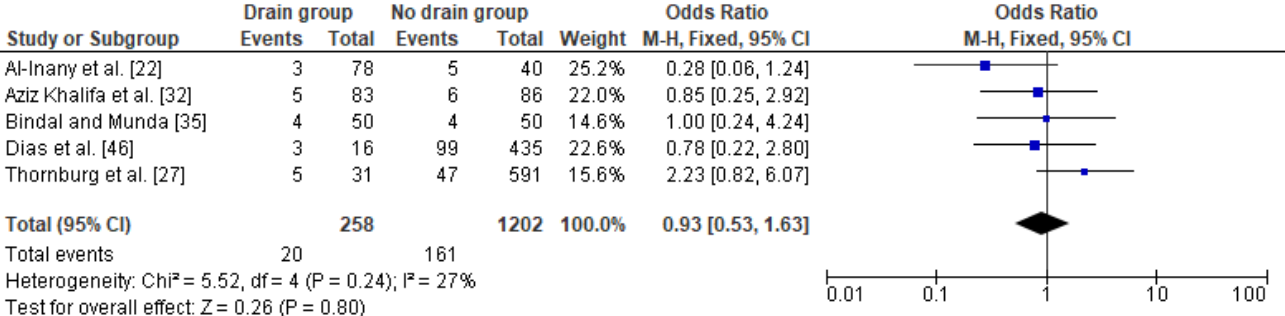
Figure 4. Forest plot for infections in the group of post-caesarean obese women with a drain and in the group of obese women without a drain. M.-H.—Mantel-Haenszel; CI—confidence interval; I 2 —heterogeneity; df—degrees of freedom.